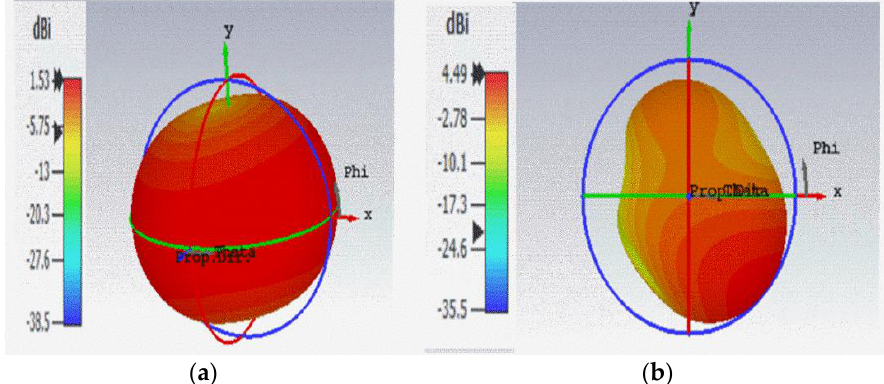
Figure 14. Simulated Gain of Antenna without AMC Backing ( a ) at 0.915 GHz ( b ) at 2.45 GHz.